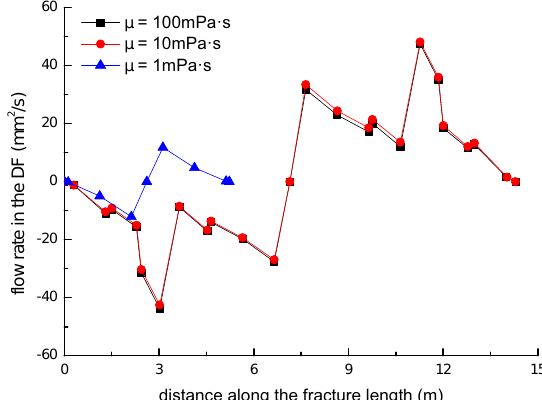
Figure 24. The flow rate curves of the DF along the fracture length direction at different levels of viscosity of fracturing fluid. The distance in the x -axis is along the direction from the lower part to the upper part of the